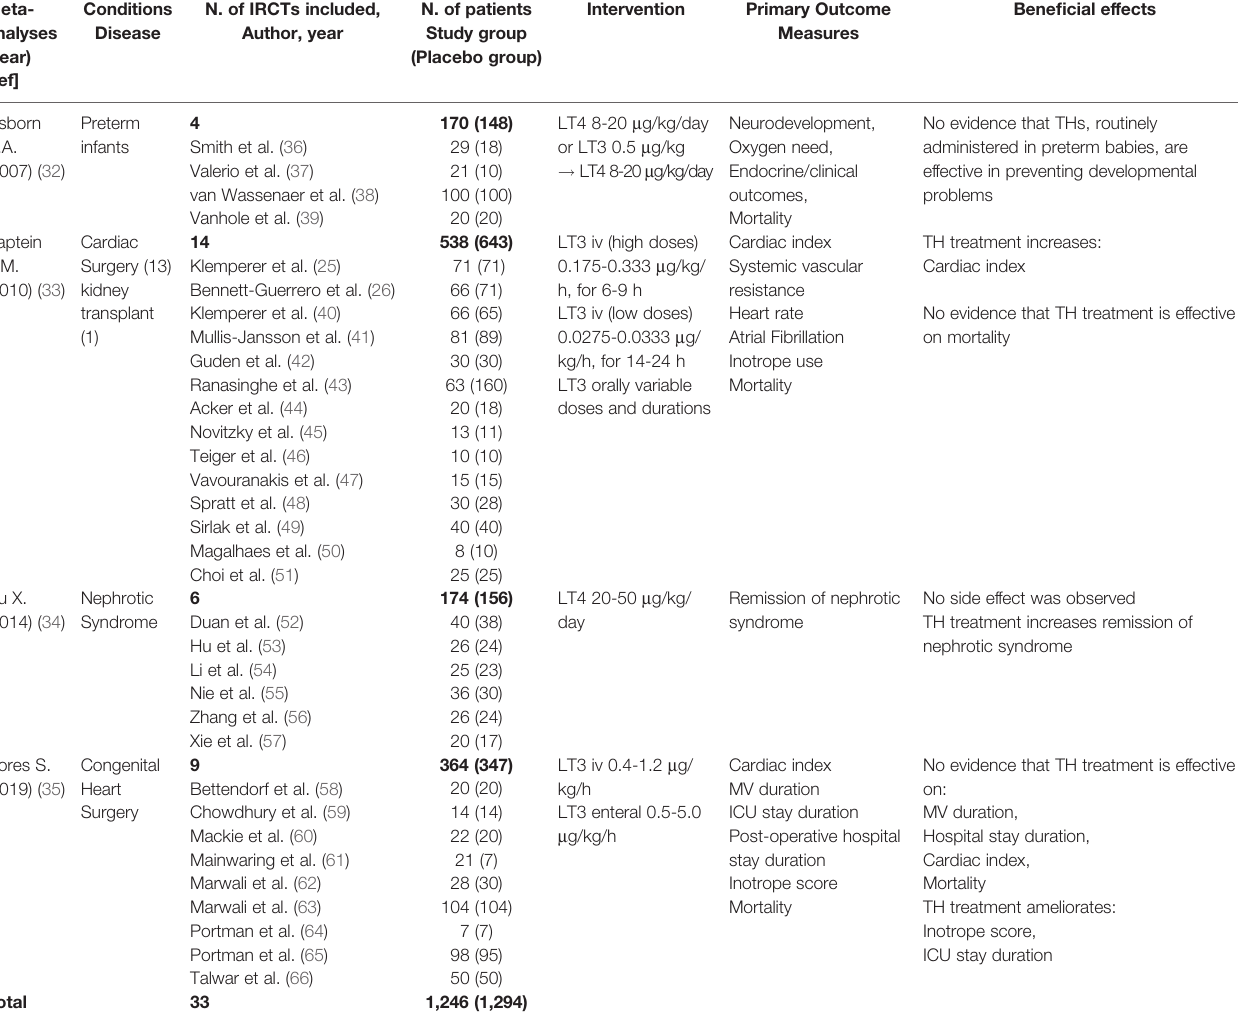
TABLE 1 | Selected metanalyses of IRCTs in